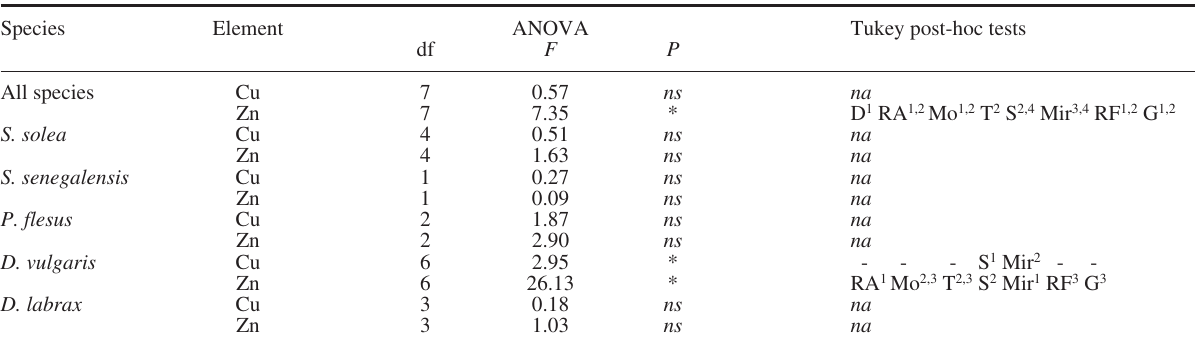
Table 6. – Inter-estuarine variation in the trace metal concentration in muscle of juveniles. Results of ANOVA comparisons and respective Tukey post-hoc multiple comparisons tests for Cu and Zn concentrations in muscle of juvenile Solea solea , Solea senegalensis , Platichthys flesus , Diplodus vulgaris and Dicentrarchus labrax among estuaries along the Portuguese coast (D, Douro; RA, Ria de Aveiro; Mo, Mondego; T, Tejo; S, Sado; Mir, Mira; RF, Ria Formosa; and G, Guadiana). * P <0.05; ns , non-significant; different numbers (superscript)